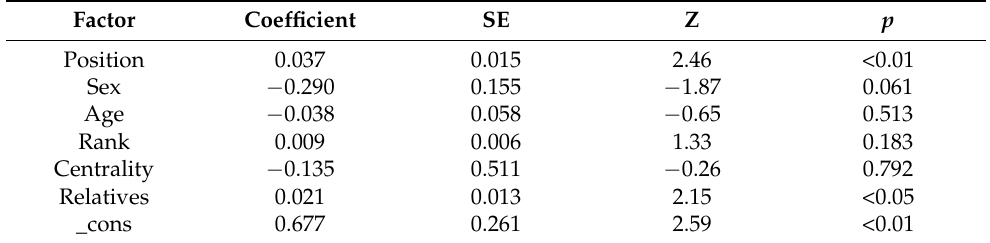
Figure 3. Eigenvector centrality coefficients of group members in the social network. Nodes represent individuals; females and males are shown in yellow and blue tones, respectively; tone gradient (from lowest to highest) indicates age class (1–4); labels represent the name of each individual; node size is proportional to social centrality; the thickness of the links represents its association index in the social network; the numbers inside each pair of brackets indicate social rank and number of relatives, respectively. Table 3. Results of the Tobit regression modelling to test the factors affecting the back-glance signal.